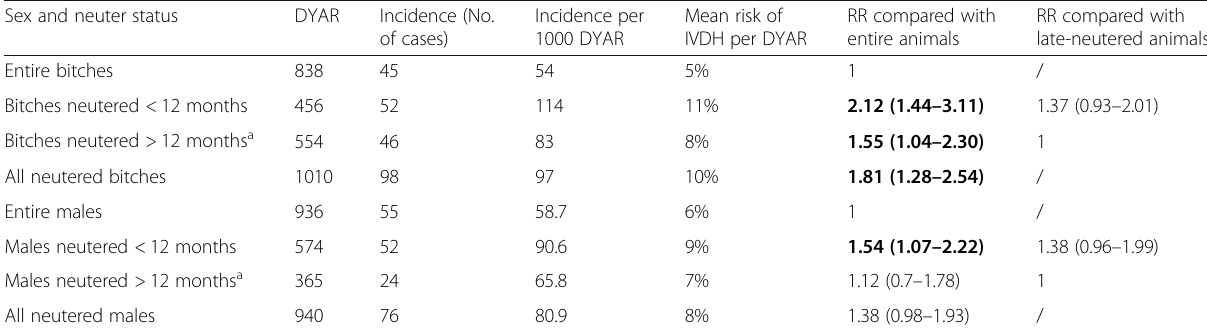
Table 5 Incidence rate and risk of IVDD in dachshunds aged between 36 and 120